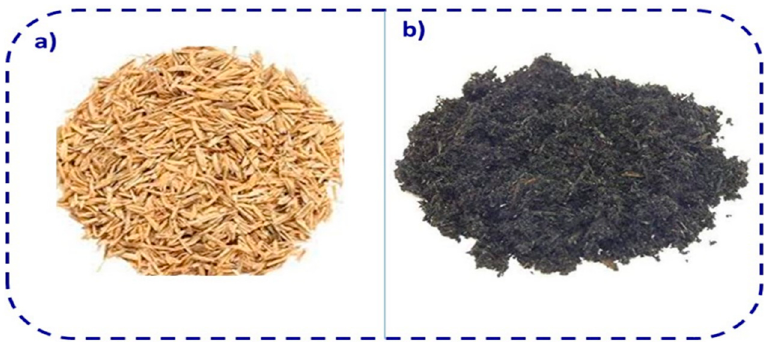
Figure 6. Photographic images of rice husk ( a ) and rice husk ash ( b ). Table 4. Chemical composition of